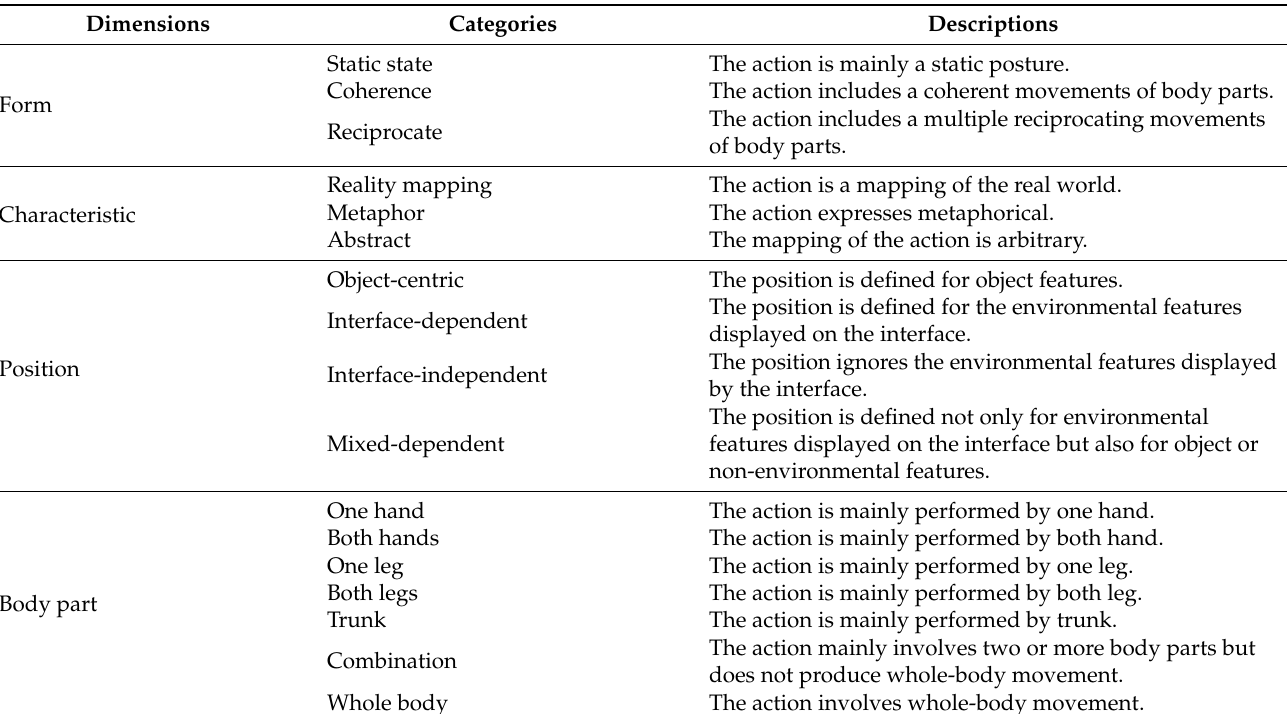
Table 3. Classification of whole-body